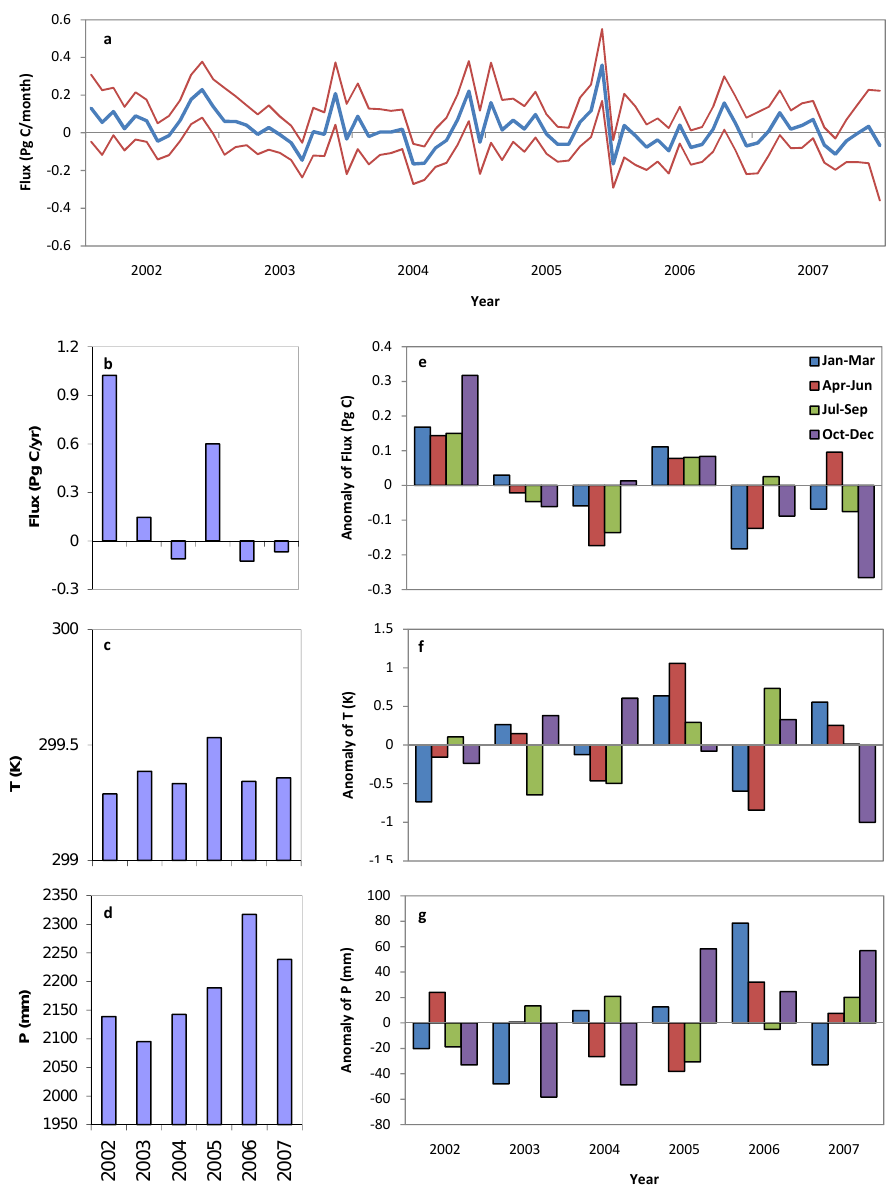
Fig. 8. The variations of inverted fluxes and climatic conditions from 2002 to 2007 in American Tropical region (Region 31). (a) The inverted monthly fluxes (thick blue line) and their uncertainties (thin red line), (b) the inverted annual fluxes, (c) the annual mean temperatures, (d) the annual precipitations, (e) the 3-monthly anomalies of inverted fluxes, (f) the 3-monthly temperature anomalies, and (g) the 3-monthly precipitation